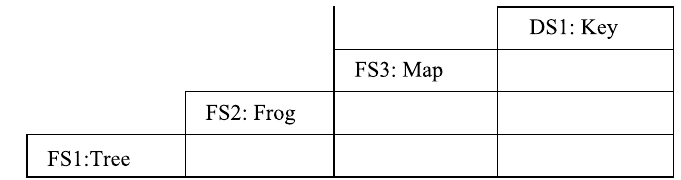
Figure 1. Taxonomy for benchmarking levels of critical awareness. Results